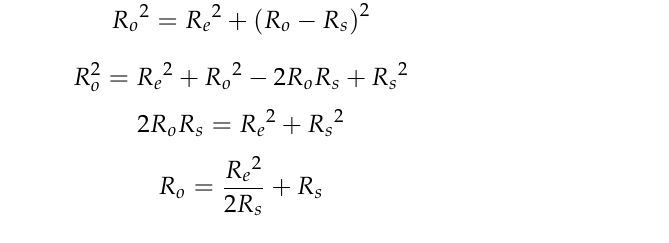
Figure 7. Circle Figure 7. Circle obstacle.